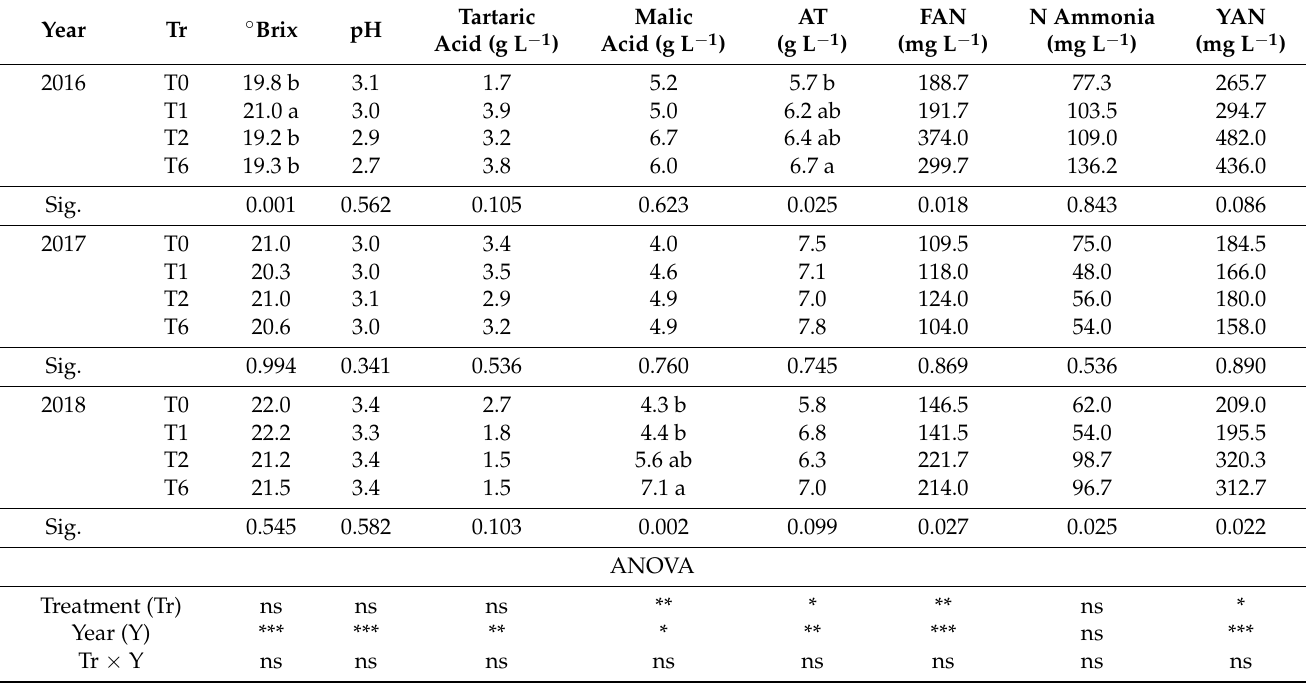
Table 3. Chemical Composition of Albariño Musts at Harvest under Different Water Treatments over Three